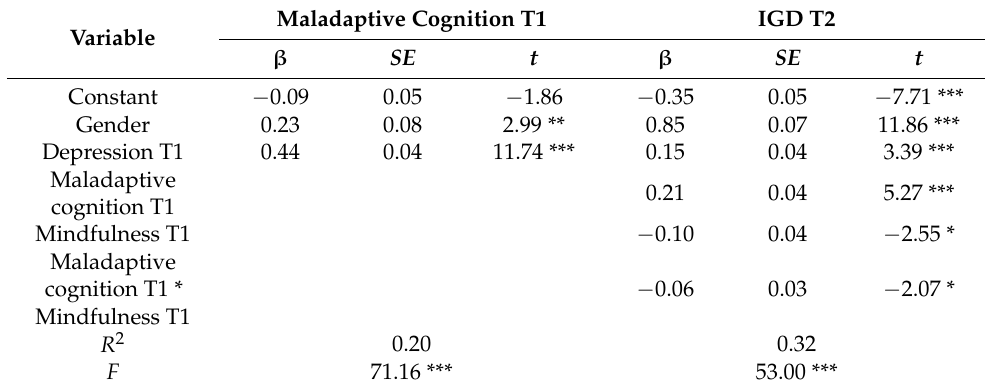
Table 3. Moderated Mediation